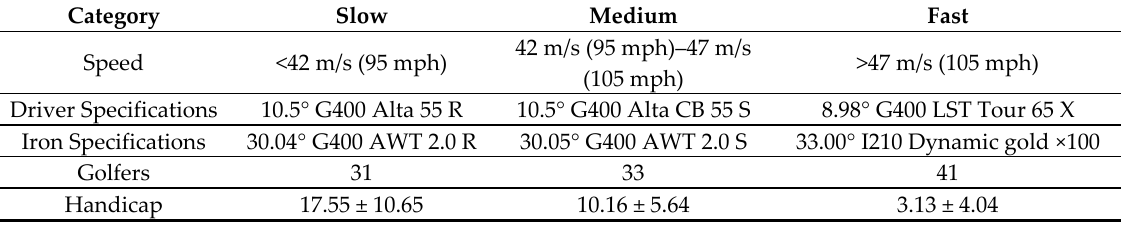
Table 2. Golfers were clustered into which clubs they would be “fit” into. All the clubs were at the PING standard length and built to a blue lie color code to match the fitting specifications of most of the tested players. R—regular flex shaft; S—stiff flex shaft; X—extra stiff flex